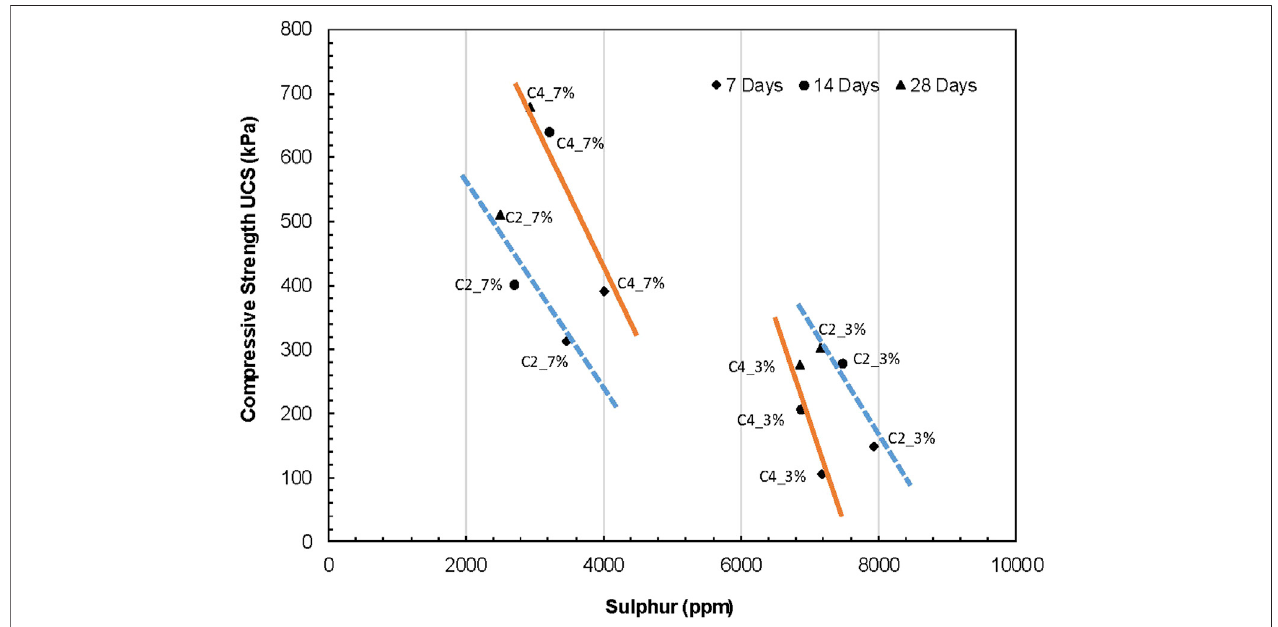
FIGURE 6 | The relationship between the UCS and total sulfur results (by combustion).